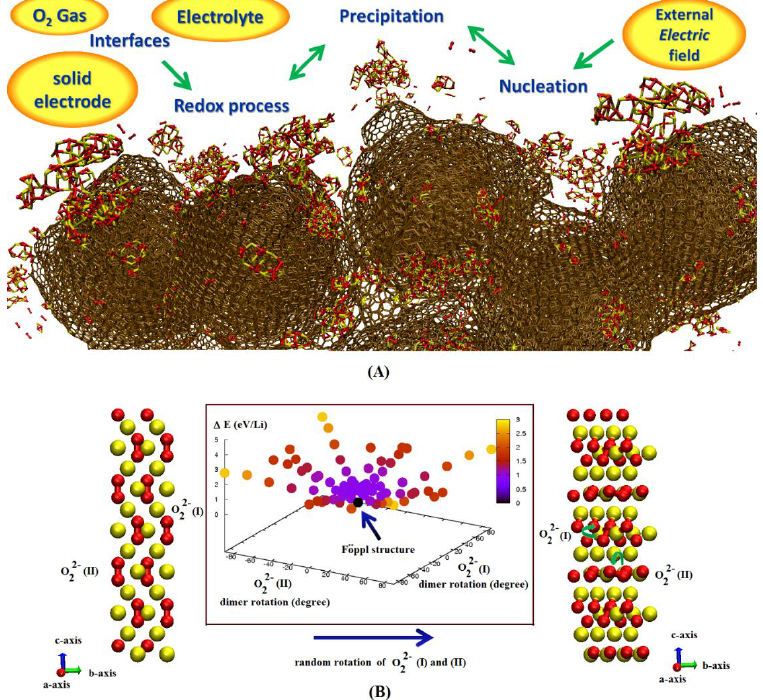
Figure 1. ( A ) A schematic description of the complex environment that might be involved in Li 2 O 2 growth in a Li-air cell; ( B ) A three-dimensional plot of total energy fluctuation ( i.e. , Δ E in eV/Li) for various possible configurations that deviate from the lowest energy structure, i.e. , Föppl structure due to the degrees of freedom involving O 22− ion rotations within the crystal lattice. The oxygen, lithium and carbon atoms are shown in red, yellow and brown color,